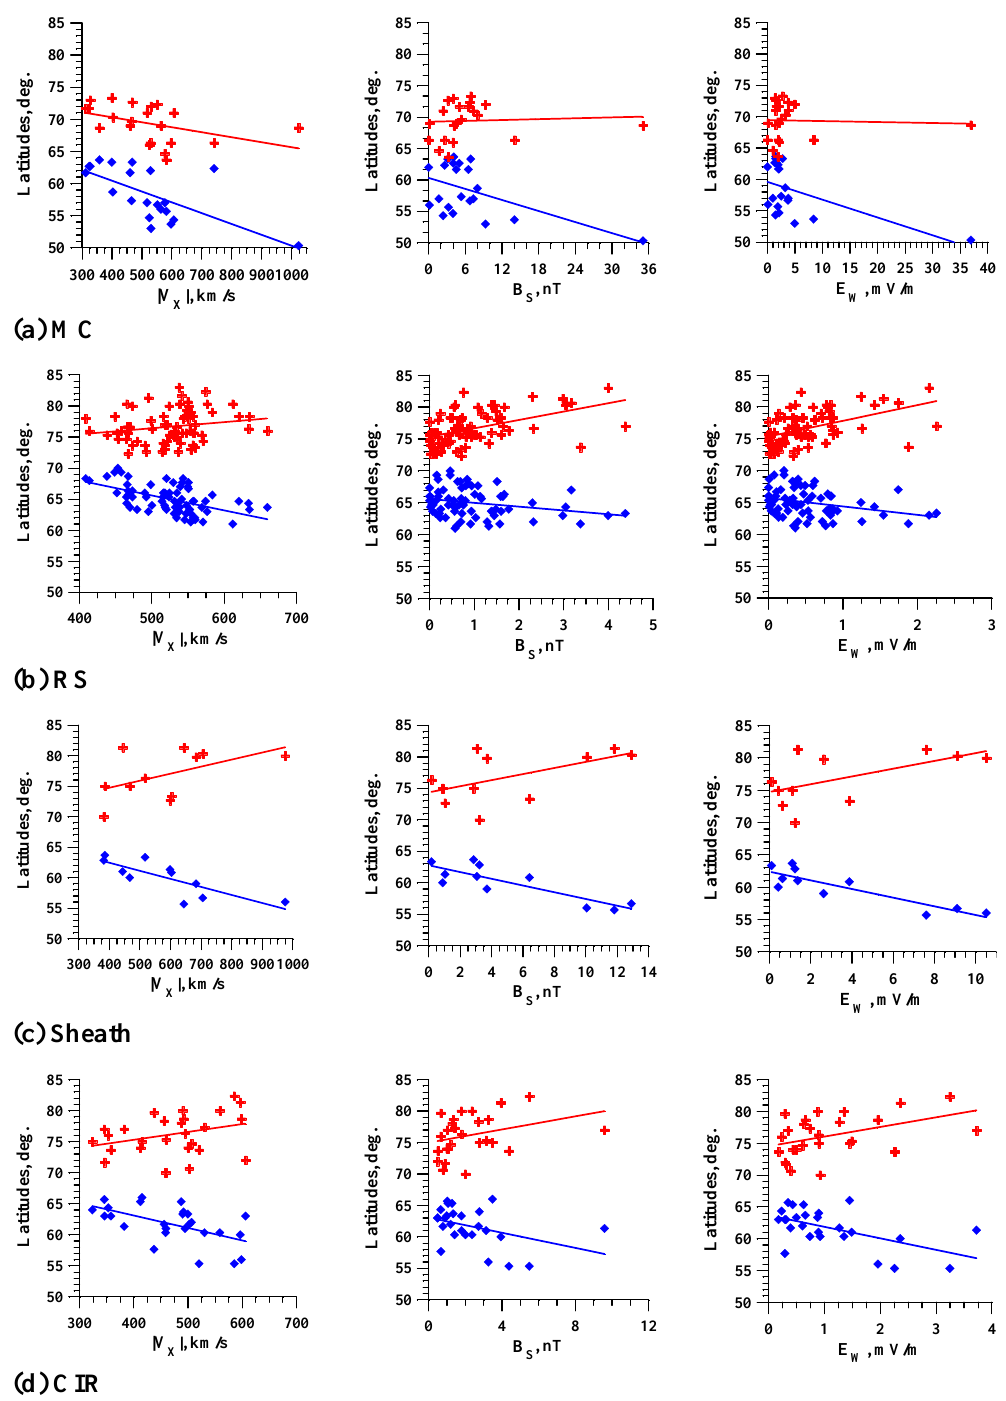
Fig. 5. Onset (blue symbols and line) and maximum (red symbols and line) latitudes of auroral bulge depending on the radial component of the solar wind velocity (the left panels), the southward IMF component (the middle panels), and the dawn-dusk component of the interplan- etary electric field (the right panels). The upper (bottom) panels show the dependencies for magnetic cloud (CIR), the second (third) panels show the dependencies for recurrent streams